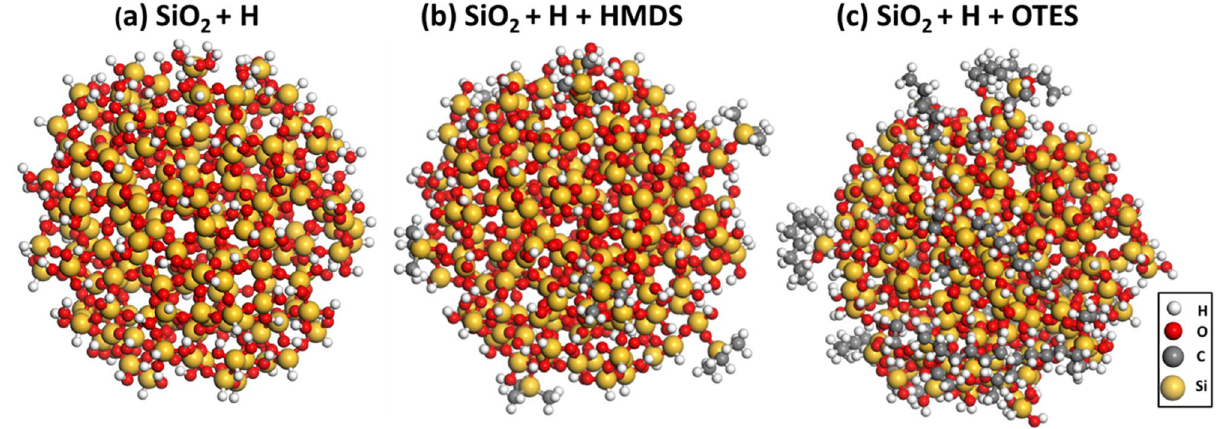
Figure 3. Atomistic models for SiO 2 nanoparticle with the surface passivated by hydrogen ( a ) and functionalized with HMDS ( b ) and OTES ( c ). The surface coverage with the functional molecules is n s = 5%. Hydrogen atoms are white, carbon atoms are grey, oxygen atoms are red and silicon atoms are yellow. The BIOVIA Materials Studio 2020 VERNO 20.1.0.2728 (https:// www. 3ds. com/ produ cts- servi ces/ biovia/ produ cts/ molec ular- model ing- simul ation/ biovia- mater ials- studio) was used to create the drawings in the